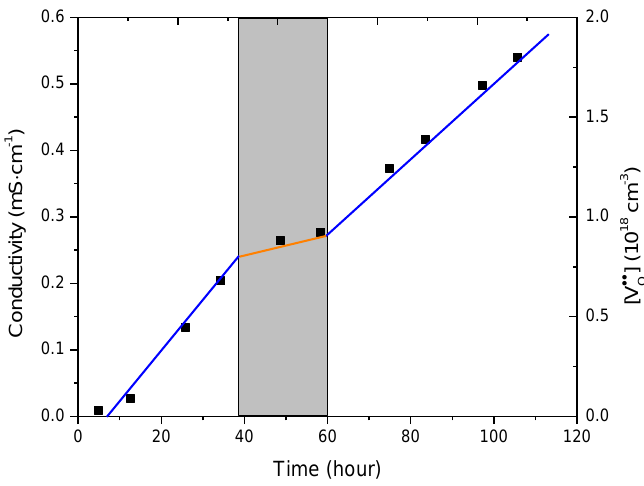
Figure 2. Ionic conductivity in a PZT-0.75%Nb buried capacitor measured over several days at 700 °C. Loss of PbO causes the increasing conductivity over time. The increasing oxygen vacancies are due to PbO evaporation: Redrawn from [27].